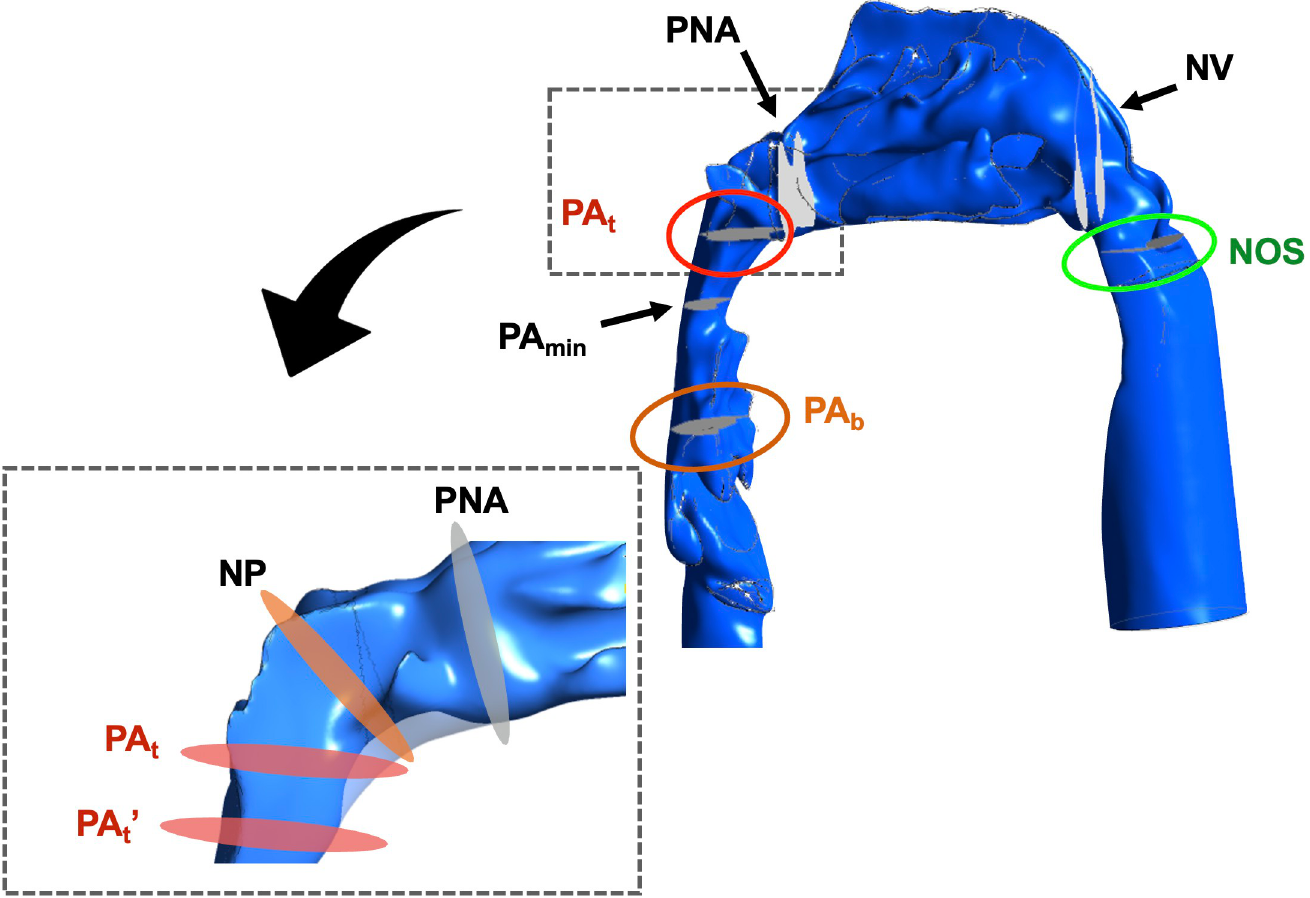
Fig 5. Cross-section of the upper airway and nasopharynx. Lateral view of the upper airway, nasopharynx and cross-section of the reference planes.